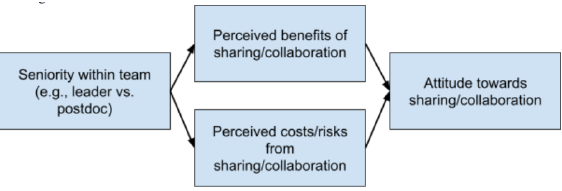
Fig. 2. Potential relationships between seniority, perceived costs/benefits and attitude towards sharing/collaboration at the individual